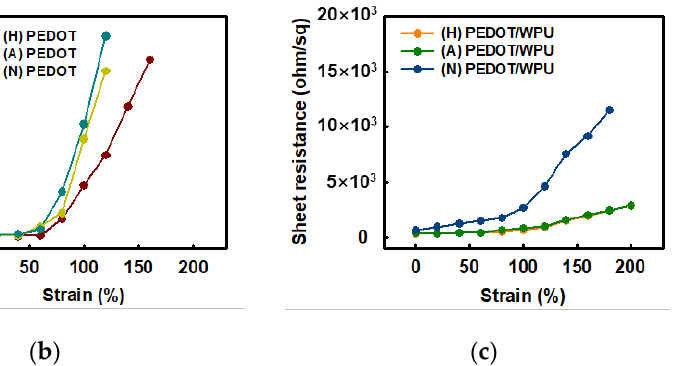
Figure 5. ( a ) Electrical conductivity of PEDOT:PSS (left) and PEDOT:PSS/nonionic WPU (2.0 wt%) (right) with PEDOT:PSS under different pH conditions; ( b ) sheet resistance of PEDOT:PSS films when TPU substrates were strained from 0% to 200%. ( c ) Sheet resistance of PEDOT:PSS films with PEDO:PSS/WPU (2.0 wt% WPU) when TPU substrates were strained from 0% to 200%. (N = PEDOT:PSS (neutral), A = PEDOT:PSS (acid), H = PEDOT:PSS (doped with sulfuric acid)).